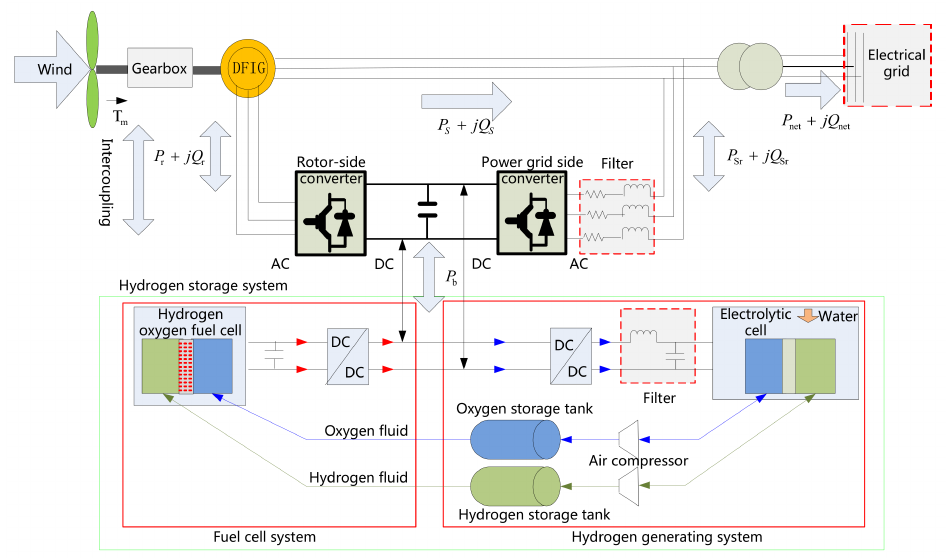
Figure 1. Energy transfers relation of the doubly fed induction generator (DIFG) coupling hydrogen energy storage system